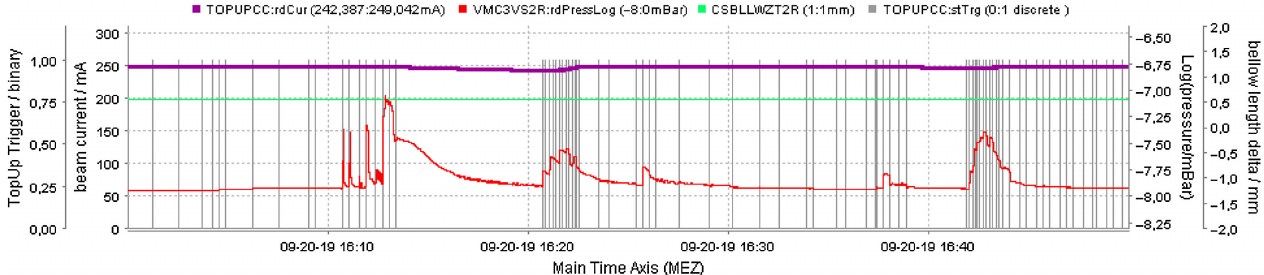
FIG. 10. CSB1 pressure gauge readout (red), beam current (magenta), and topup injection trigger times (light gray) (no bellow movements — green). Additional injections may trigger short pressure bursts (leftmost spikes, decay times ∼ 10 1 s), processes of slow conditioning ( ∼ 10 2 s), and also sudden pressure decrease events as shown here for a sample time interval.